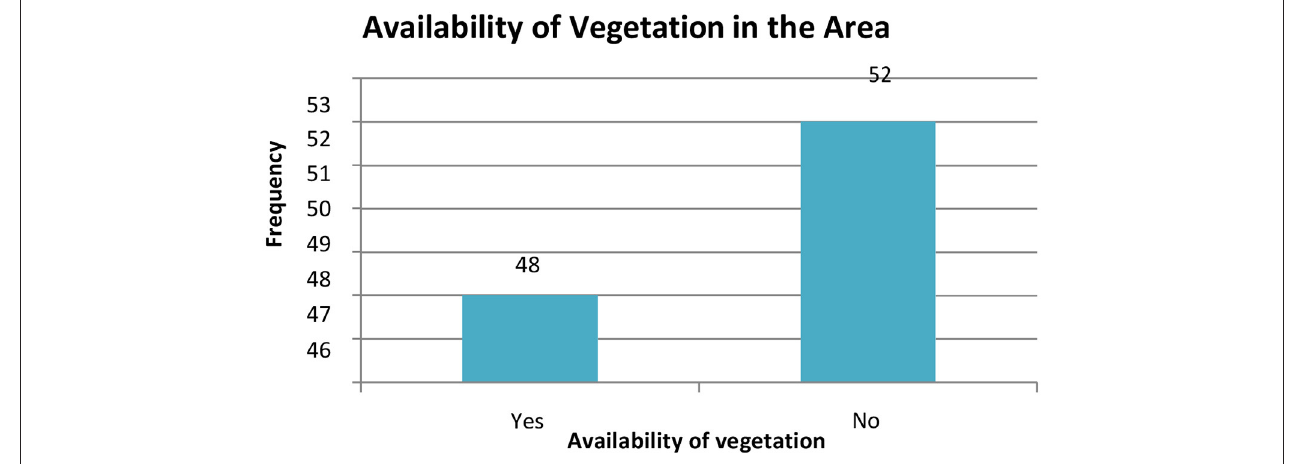
FIGURE 15 | Availability of vegetation in the area.